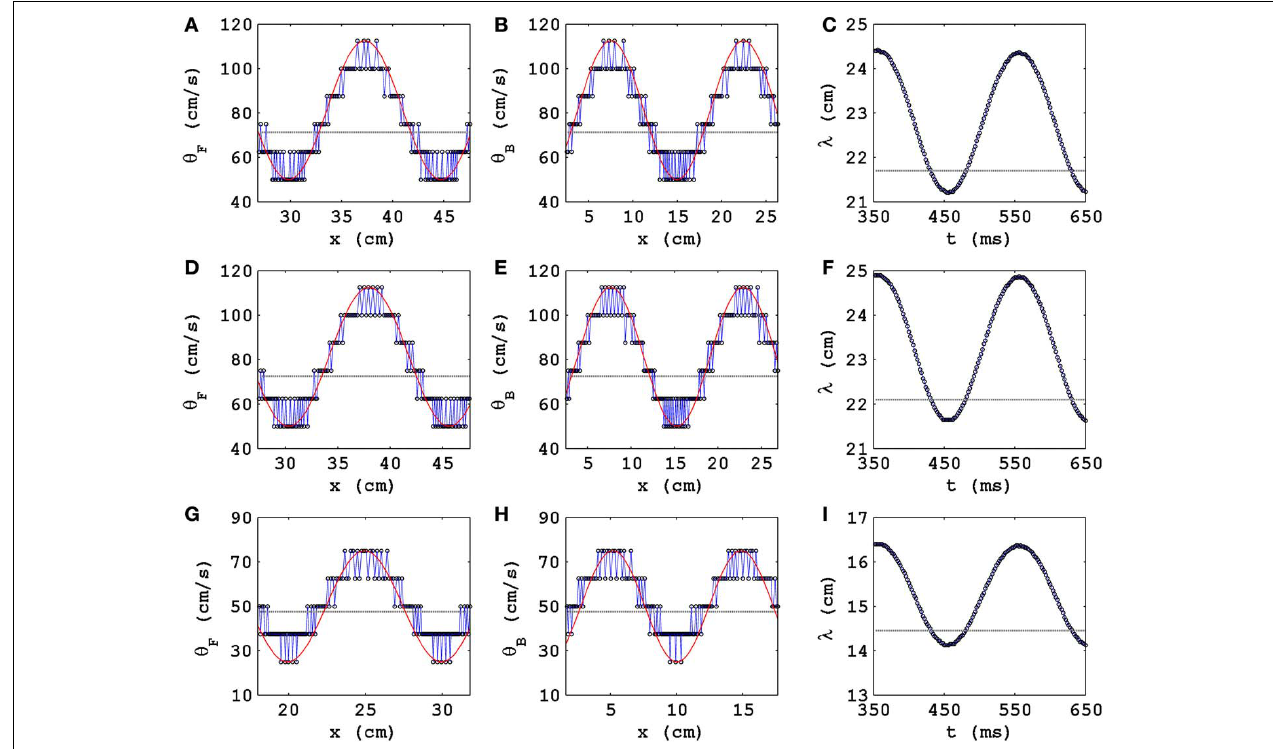
δ t = 0 . 02ms, and δ x = 0 . 25mm. We use the representative PD parameter values A x = 0 . 3 and f x = 5 . 0Hz for the TP06 model. Open circles show the values from our calculation; the red lines show smooth sinusoidal envelopes; in the absence of PD, θ (cid:3) 70 . 6cm/s, (cid:3) 71 . 7cm/s, and (cid:3) 47cm/s, respectively, for above three parameter sets [gray, dashed lines in (A,B) ]; in (C) the gray, dashed line shows the value of λ that we obtain in the absence of